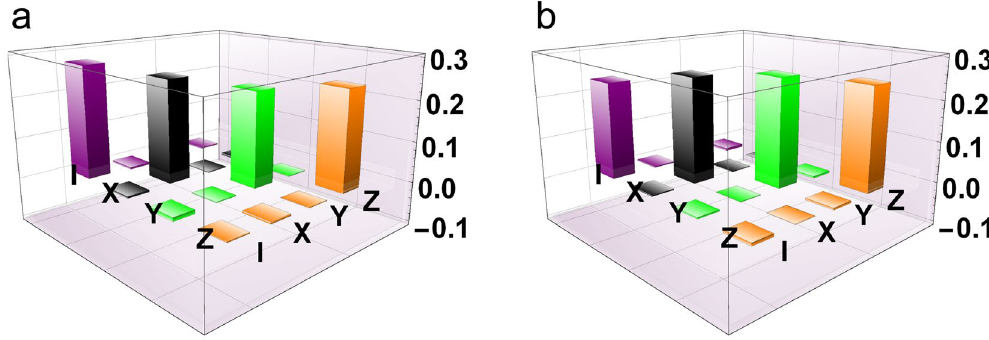
Figure 3. The real part of the reconstructed process matrix. ( a ) For the forward propagation. ( b ) For the backward propagation.